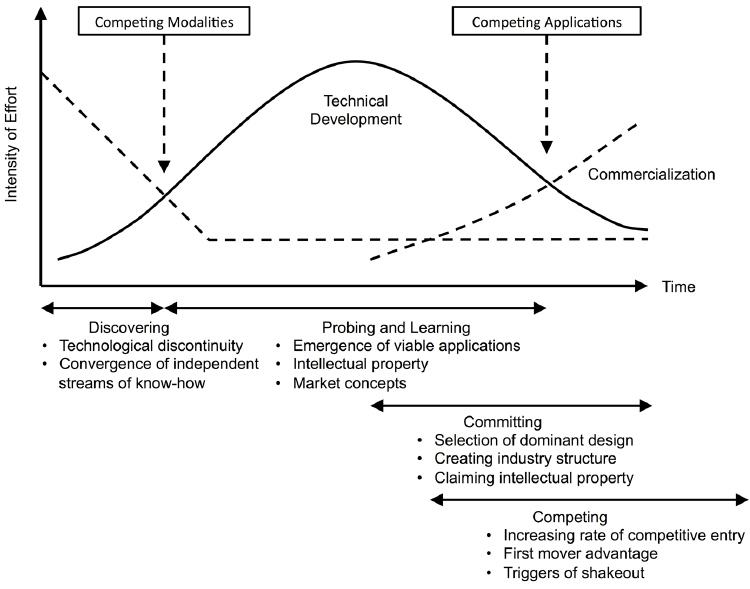
Figure 1. How emerging knowledge evolves (redrawn from [9]).